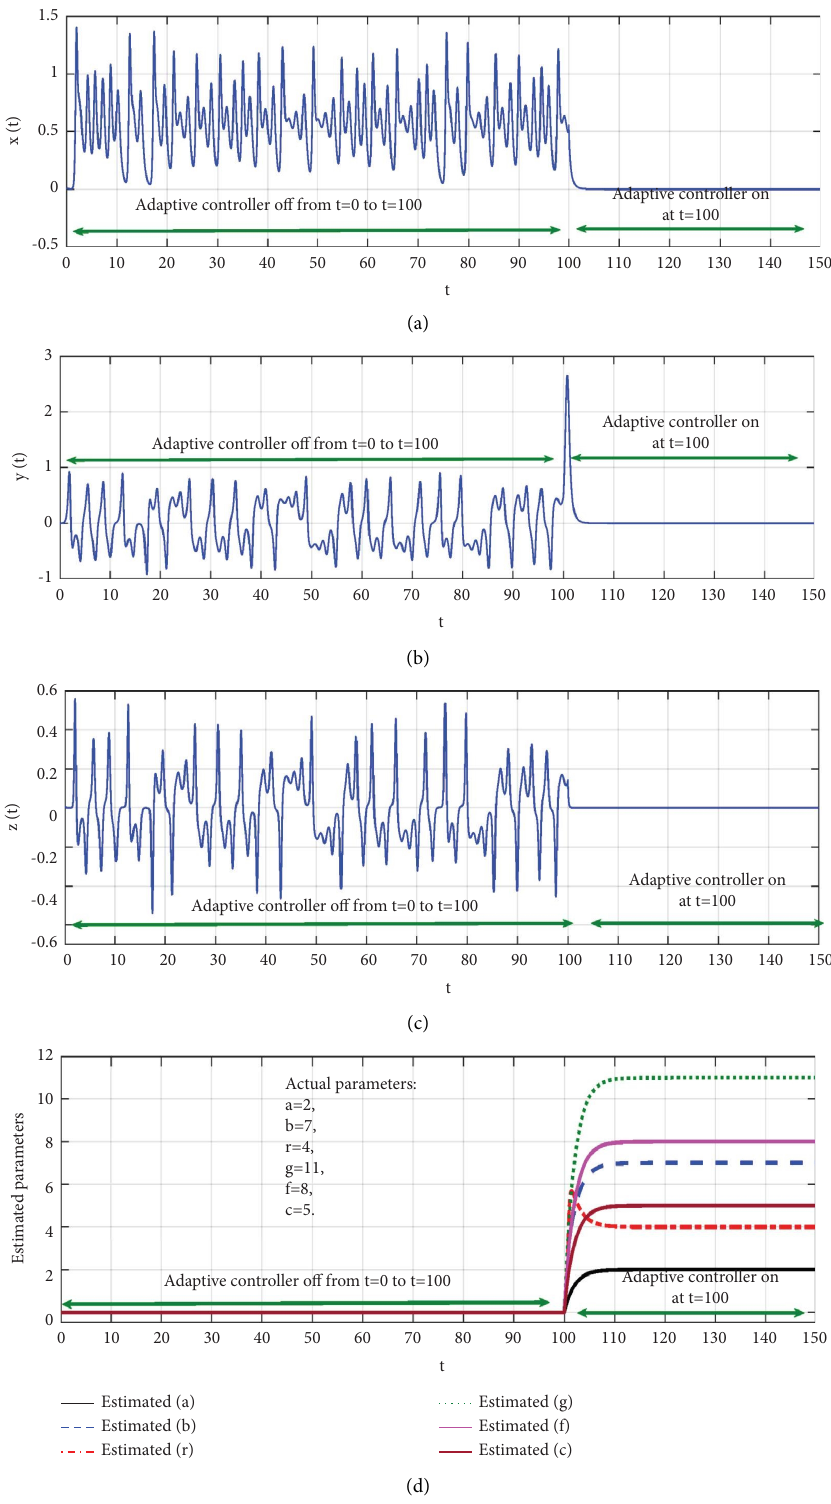
Figure 10: Te evolution of the chaotic system time response before and after chaos control when the system parameters a � 2 ,b � 7 , r � 4 ,g � 11 ,f � 8 , c � 5, control gains δ x ( 0 ) � y ( 0 ) � z ( 0 ) � 0 . 01 , 􏽥 a ( 0 ) � 􏽥 b ( 0 ) � 􏽥 r ( 0 ) � 􏽥 g ( 0 ) � 􏽥 f ( 0 ) � 􏽥 c ( 0 ) � 0 . 0. (a–c) the evolution of the system states x ( t ) , y ( t ) , and z ( t ) before chaos control on the interval 0 ≤ t < 100 and after control on the interval 100 ≤ t ≤ 150, and (d) the evolution of the system estimated parameters 􏽥 a, 􏽥 b, 􏽥 c, 􏽥 g, 􏽥 f, and 􏽥 r